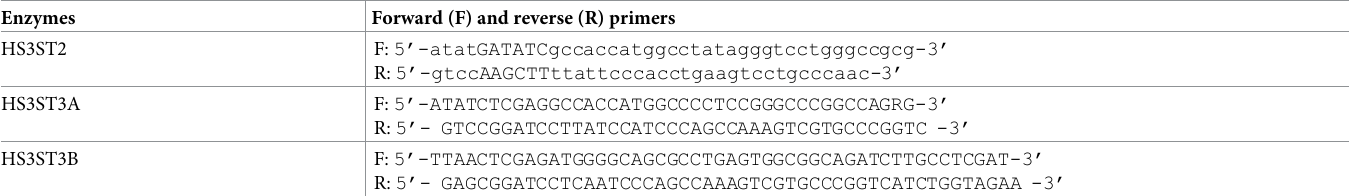
Table 1. Sets of primers used for plasmid construction. The underlined sequences represent restriction sites for the generation of PCR fragments.